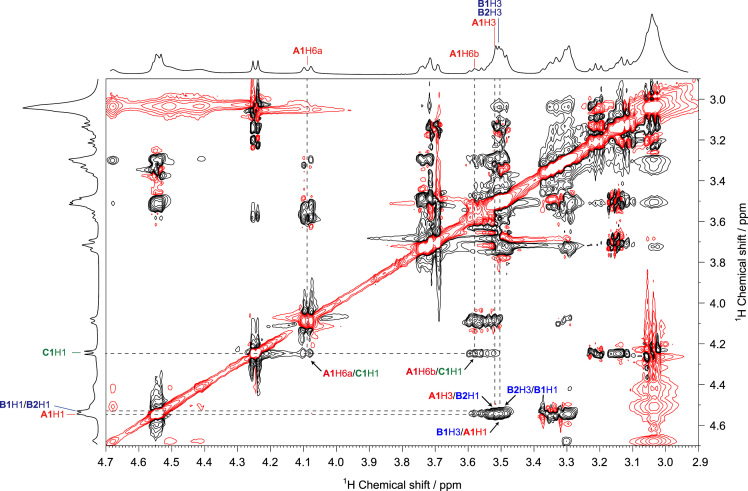
ROESY spectrum of SPG in DMSO-d6 at 363 K. The arrows indicate the interresidual correlations between B1H3–A1H1, A1H3–B2H1, B2H3–B1H1, A1H6a–C1H1, and A1H6b–C1H1 via glycosidic bonds.